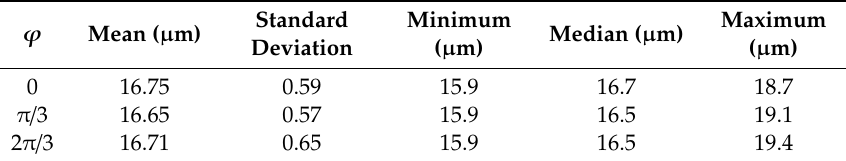
  0 Figure 12. Radius of curvature ( ρ ) in relation to the scanned path ( L ) with longitude  φ = 0, π  , and 2π  ,  respectively.